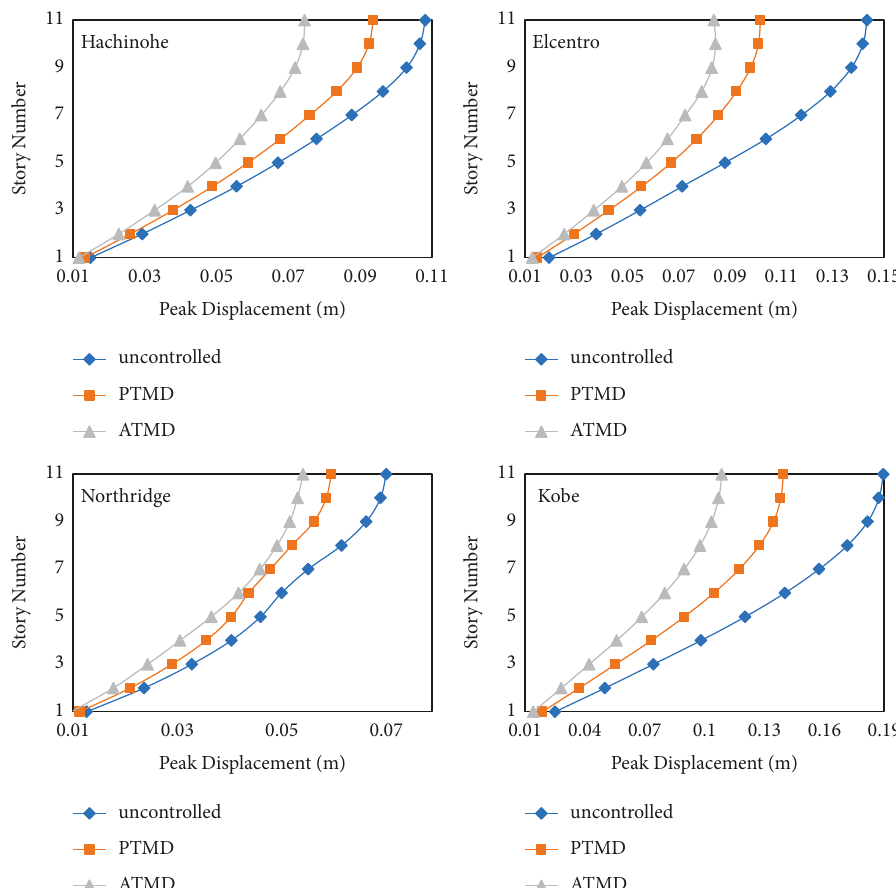
Figure 6: Maximum displacement of structural floors with PTMD and ATMD